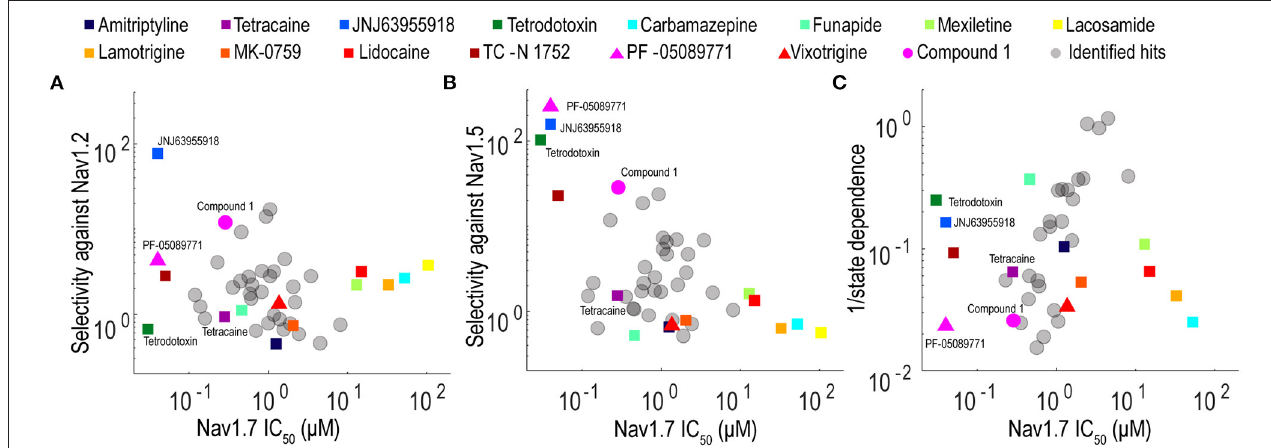
FIGURE 6 | Potency, selectivity, and state dependence of tool compounds and identified hits. (A) For each Nav1.7 inhibitor, its subtype selectivity against Nav1.2, defined as the ratio of Nav1.2 IC 50 value over Nav1.7 IC 50 value, was plotted against its Nav1.7 IC 50 value. (B) For each Nav1.7 inhibitor, its subtype selectivity against Nav1.5, defined as the ratio of Nav1.5 IC 50 value over Nav1.7 IC 50 value, was plotted against its Nav1.7 IC 50 value. (C) For each Nav1.7 inhibitor, its reciprocal of state dependence was plotted against its potency on Nav1.7. In all three panels, the compounds with desired properties (potent, subtype selective and less state-dependence) distribute to the upper left quadrant.